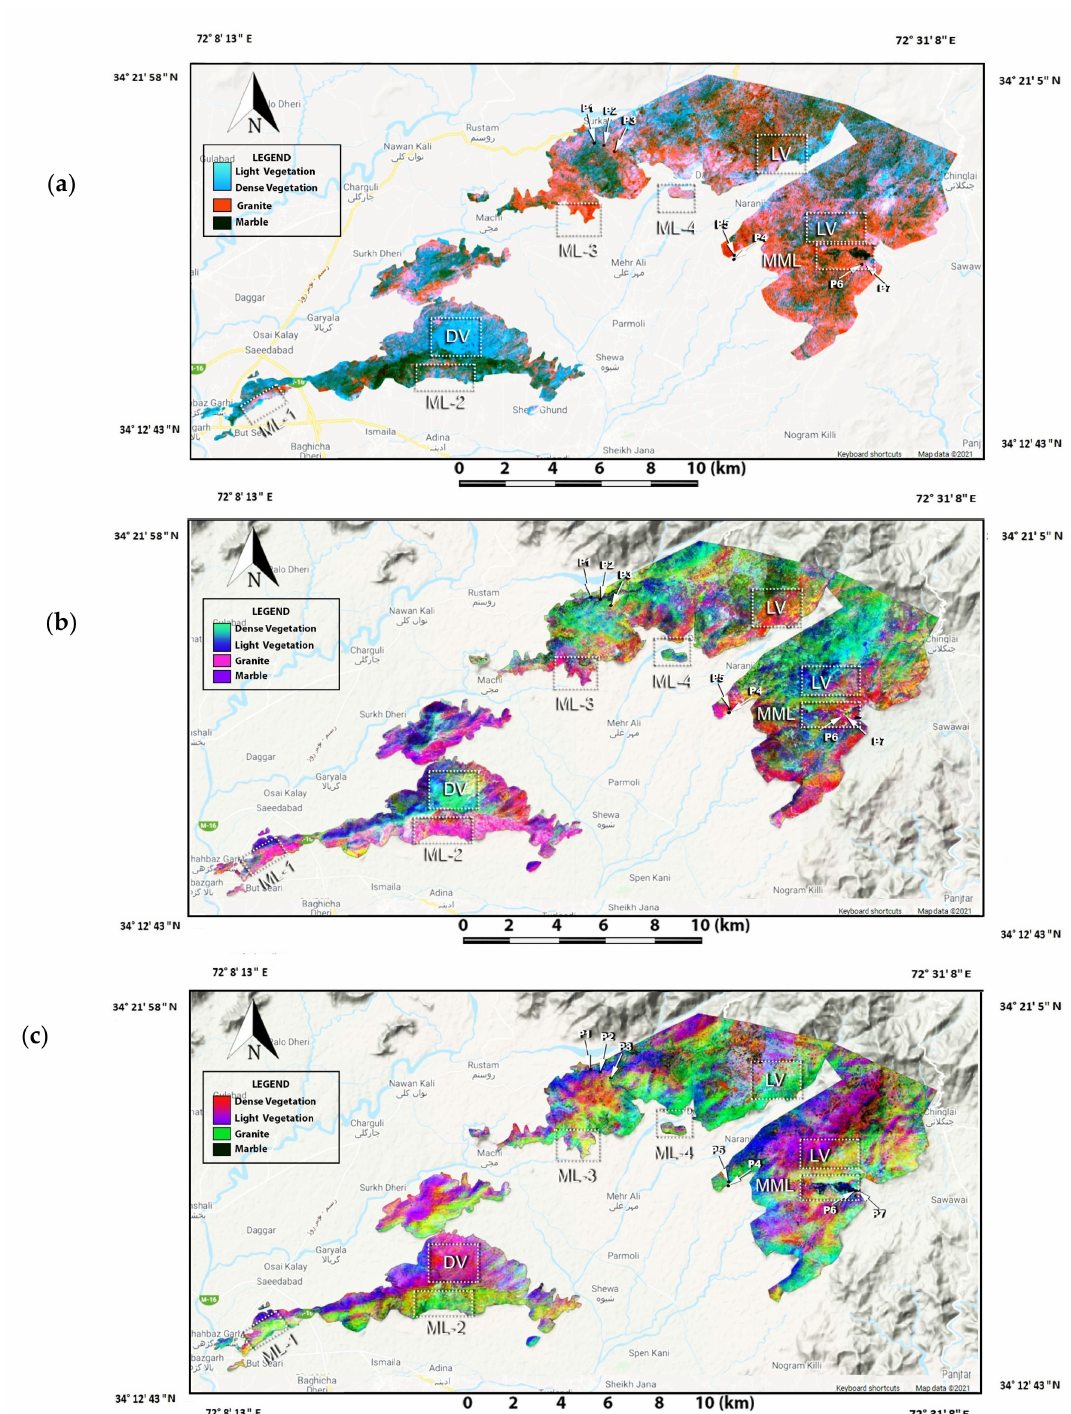
Figure 10. ( a ) Weighted false-color composite (FCC) image from selected FPCS components (stretched Sentinel-2 MSI data (PC3), raw Landsat (PC4), and stretched Landsat data (PC3) weights were 1.5, 0.375, and 1.25, respectively). Granite occurrences were observed at P1 (72 ◦ 20 (cid:48) 31 (cid:48)(cid:48) E, 34 ◦ 20 (cid:48) 26 (cid:48)(cid:48) N). DV was observed at P2 (72 ◦ 20 (cid:48) 50 (cid:48)(cid:48) E, 34 ◦ 20 (cid:48) 21 (cid:48)(cid:48) N), and low vegetation (LV) was observed at P3 (72 ◦ 21 (cid:48) 7 (cid:48)(cid:48) E, 34 ◦ 20 (cid:48) 12 (cid:48)(cid:48) N). While granite was easily discernible in non-vegetated areas at P4 (72 ◦ 24 (cid:48) 29.5 (cid:48)(cid:48) E, 34 ◦ 17 (cid:48) 47 (cid:48)(cid:48) N) and P5 (72 ◦ 24 (cid:48) 17 (cid:48)(cid:48) E, 34 ◦ 17 (cid:48) 51 (cid:48)(cid:48) N), and marble outcrops were observed at P6 (72 ◦ 28 (cid:48) 7 (cid:48)(cid:48) E, 34 ◦ 17 (cid:48) 36 (cid:48)(cid:48) N) and P7 (72 ◦ 28 (cid:48) 10 (cid:48)(cid:48) , 34 ◦ 17 (cid:48) 37 (cid:48)(cid:48) N); ( b ) FCC image of PC4, PC5, and PC6 of PCA applied to the stacked raw bands of all the three datasets; ( c ) FCC image of PC1, PC2, and PC3 of PCA applied to the stacked stretched bands of all the three